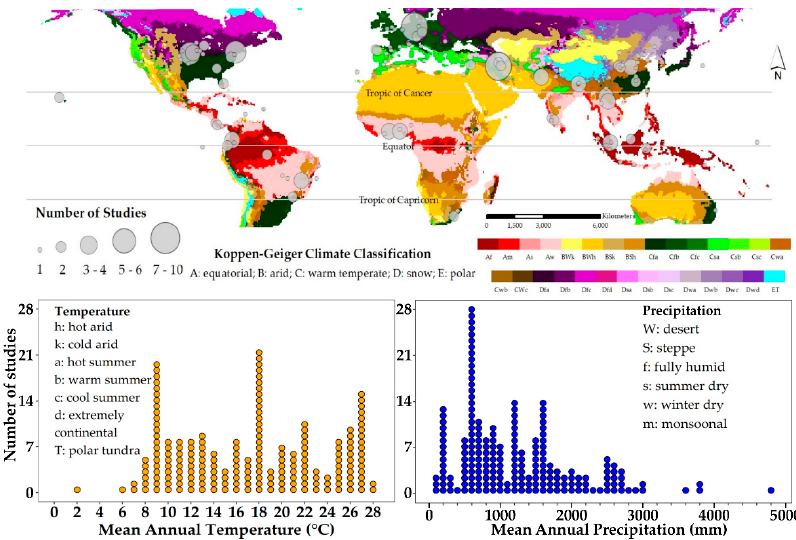
Figure 1. Map of locations and climate conditions for all study sites included in this meta-analysis of observations or estimates of throughfall, stemflow, and interception for